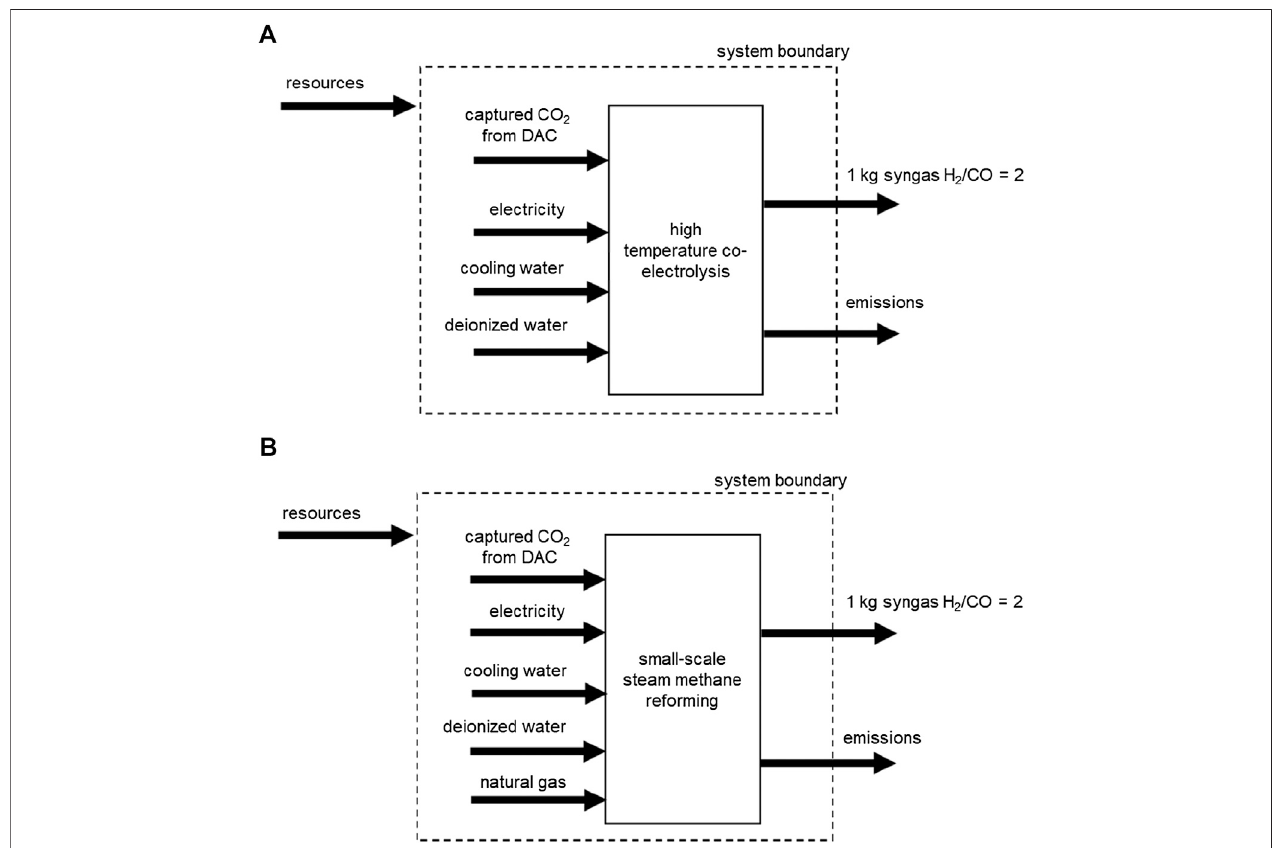
FIGURE 1 | System boundaries of cradle-to-gate syngas production pathways considered: (A) syngas production by HT-co-electrolysis, (B) conventional syngas production by small-scale SMR.